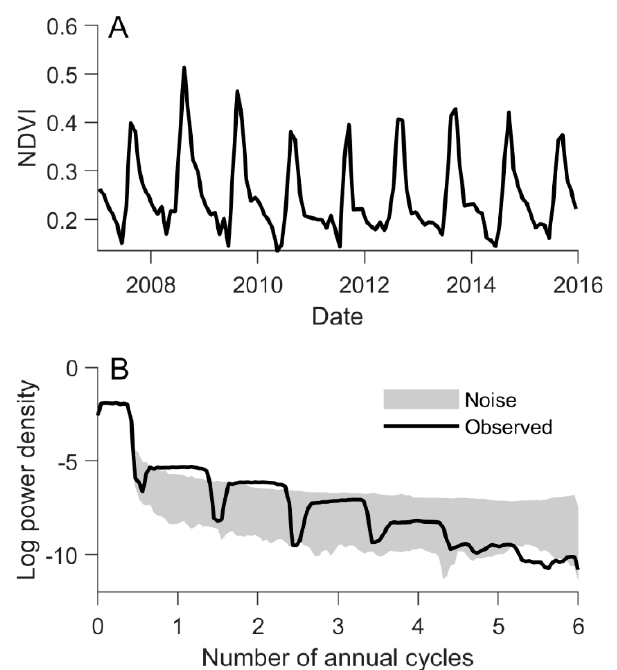
Figure 2. Defining the number of annual phenological cycles at an example pixel (11.75°N, 25.25°E) using the multitaper method (MTM). ( A ) Normalized difference vegetation index (NDVI) time series, and ( B ) log-transformed power spectral density (PSD) at an example pixel. To determine the number of annual NDVI, solar-induced chlorophyll fluorescence (SIF), and vegetation optical depth (VOD) phenological cycles at a given pixel, the observed PSD was compared to the 99th percentile of PSDs from an ensemble of noise-only time series with the same mean and variance.